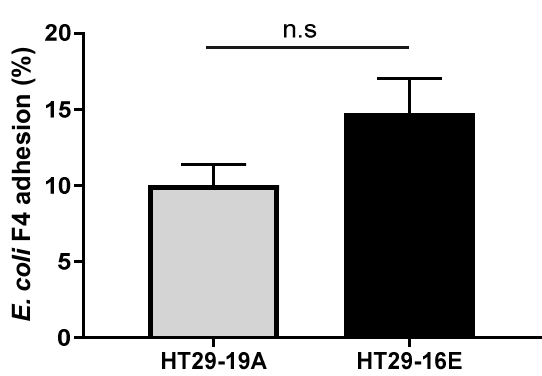
Figure 3. E. coli F4 adhesion assay with HT29-19A and HT29-16E cells. HT29-19A and HT29-16E cell monolayers were incubated with Dulbecco’s Modified Eagle’s medium (DMEM) without antibiotics for 1 h before adding E. coli F4, and then incubated for an additional 2 h. Adherent E. coli F4 was quantified by CFU counting on MacConkey agar plates, and the percentage of adhesion was normalized by initial E. coli F4 bacterial load. Data are expressed as mean ± SEM of nine experiments performed in triplicates; n.s.: not significant. A student t-test was performed to assess statistically significant differences between both cell lines.